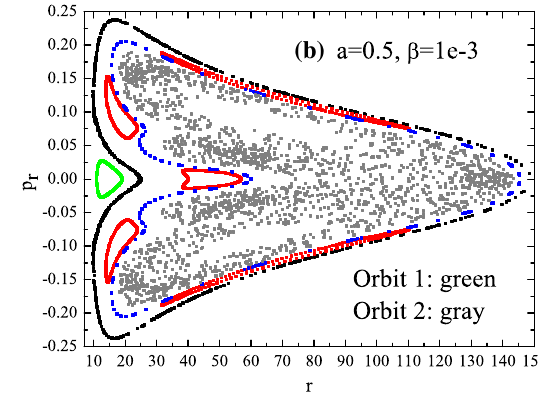
Fig. 1 a Hamiltonian errors Δ = K for the explicit symplectic algorithm S2 and Δ = − H − 1 / 2 for the second-order implicit and explicit mixed symplectic method IE2. The parameters are E = 0 . 995, L = 4 . 6, a = 0 . 5 and β = 0 . 001. Orbits 1 and 2 have their initial separations r 0 = 11 and 75, respectively. The other initial conditions are θ = π/ 2, p r = 0 and p θ > 0 given by Eqs. (14) and (16). h = 1 is